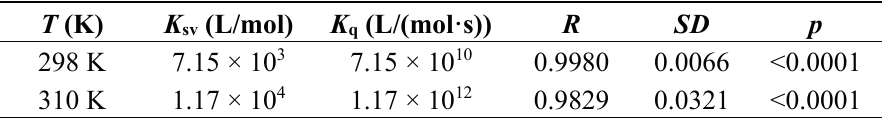
Table 1. The quenching constants and binding parameters of LYS to GA solution system. T (K)